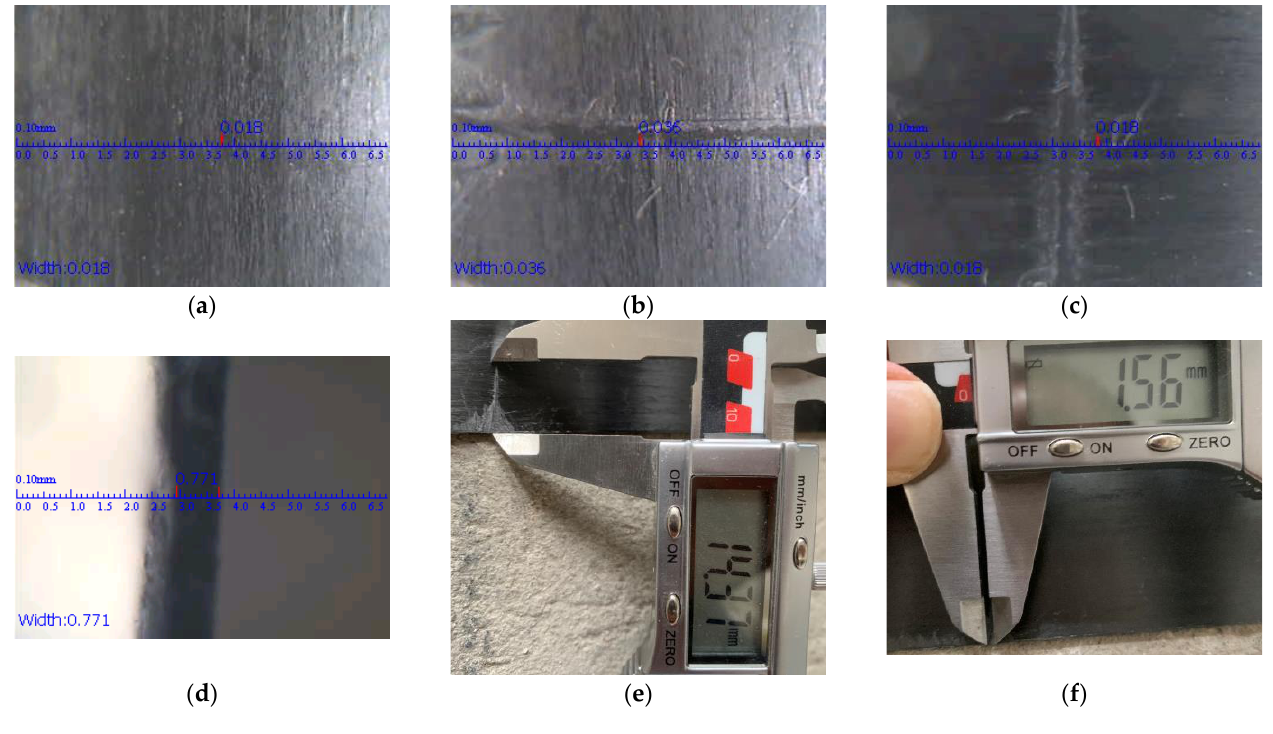
Figure 5. Damage to the laminate: ( a ) undamaged laminate, ( b ) damage image perpendicular to the fibre, ( c ) damage image parallel to the fibre, ( d ) decrease in laminate thickness at the site of damage, ( e ) damage height, and ( f ) damage width.